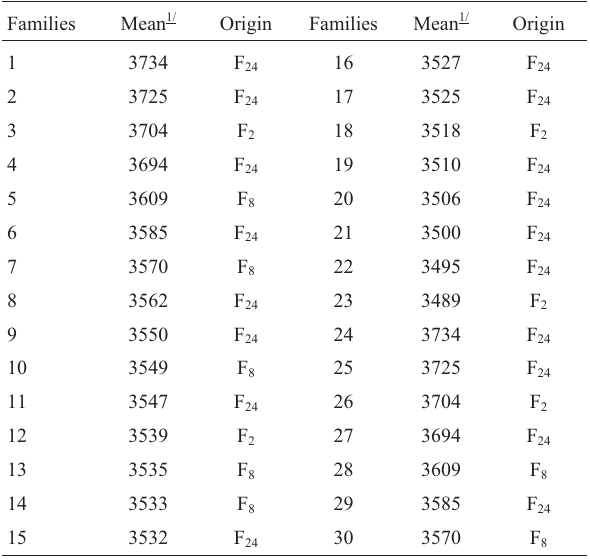
Table 4 - Mean grain yield (kg/ha) of the best performing 30 families.